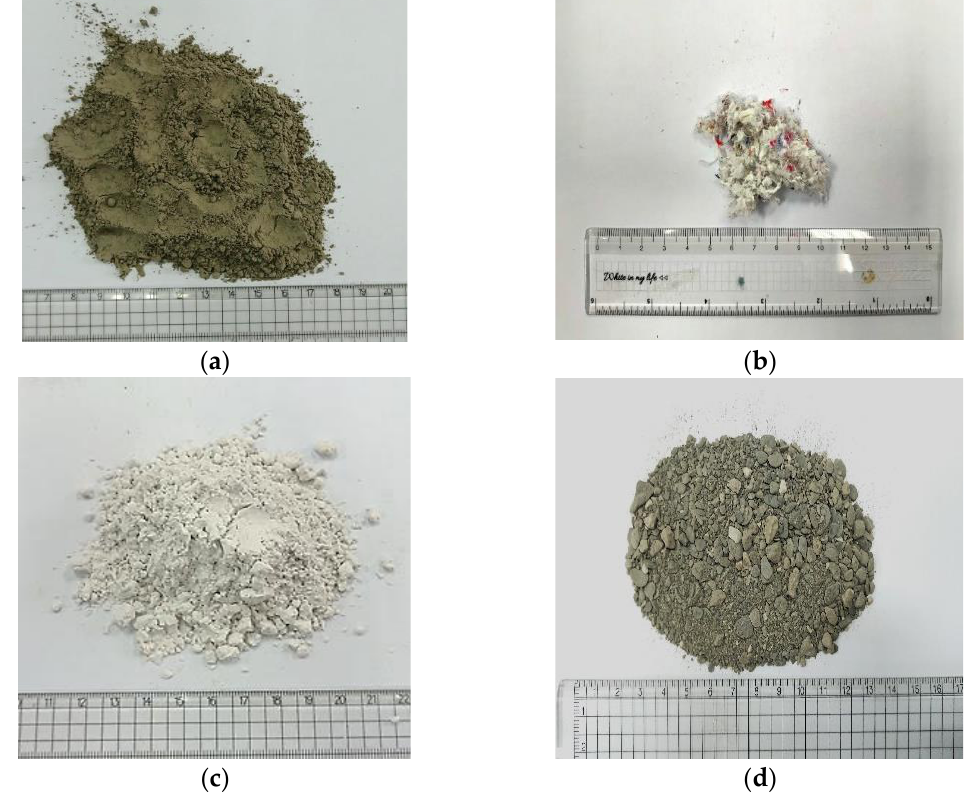
Figure 1. Test materials: ( a ) cement, ( b ) waste PE, ( c ) GGBFS, and ( d ) sand.